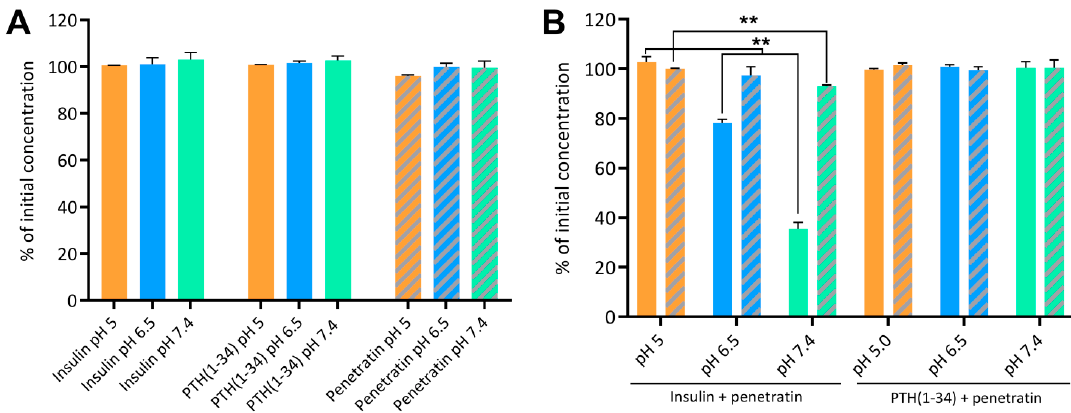
Figure 2. Insulin, PTH(1 ‐ 34), and penetratin left in the supernatant following ultracentrifugation alone ( A ) or as physical mixtures of insulin and penetratin or PTH(1 ‐ 34) and penetratin ( B ) at pH 5, 6.5, or 7.4. Full columns represent insulin or PTH(1 ‐ 34) and dashed columns represent penetratin. Data are presented as % of initial concentration (N = 2, mean ± SD). Level of significance is **: p < 0.01 (unpaired t ‐ test).